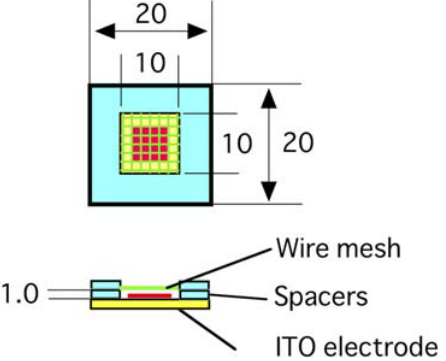
Figure 1. An electroformation chamber with a planar indium tin oxide (ITO) formation electrode and a counter electrode of wire mesh. Lipid (shown in red) was deposited on the formation electrode. The unit of length is millimeter.